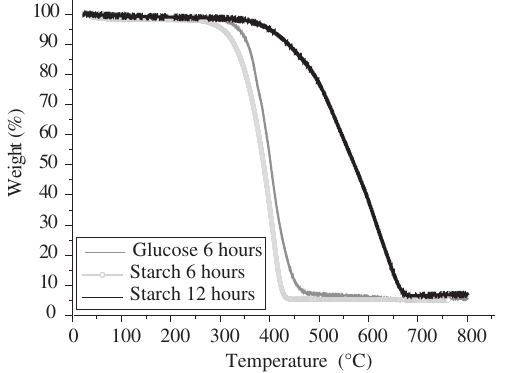
0 Figure 1. Thermogravimetric analysis of PtRu/Carbon materials after thermal treatment under dry oxygen (20 mL/min) and heating rate of 5 °C/min.